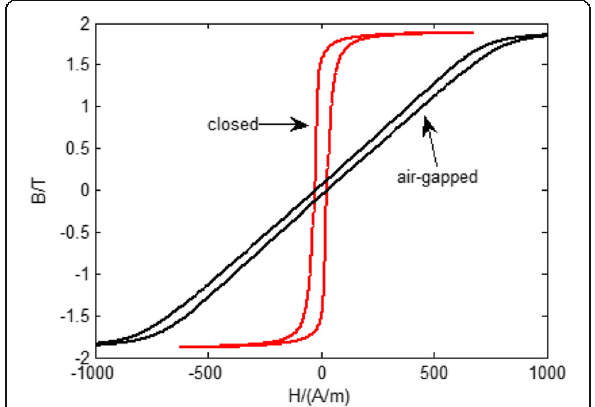
Fig. 10 Comparison of limiting hysteresis loops of closed core and air-gapped core with gap ratio of 0.0005